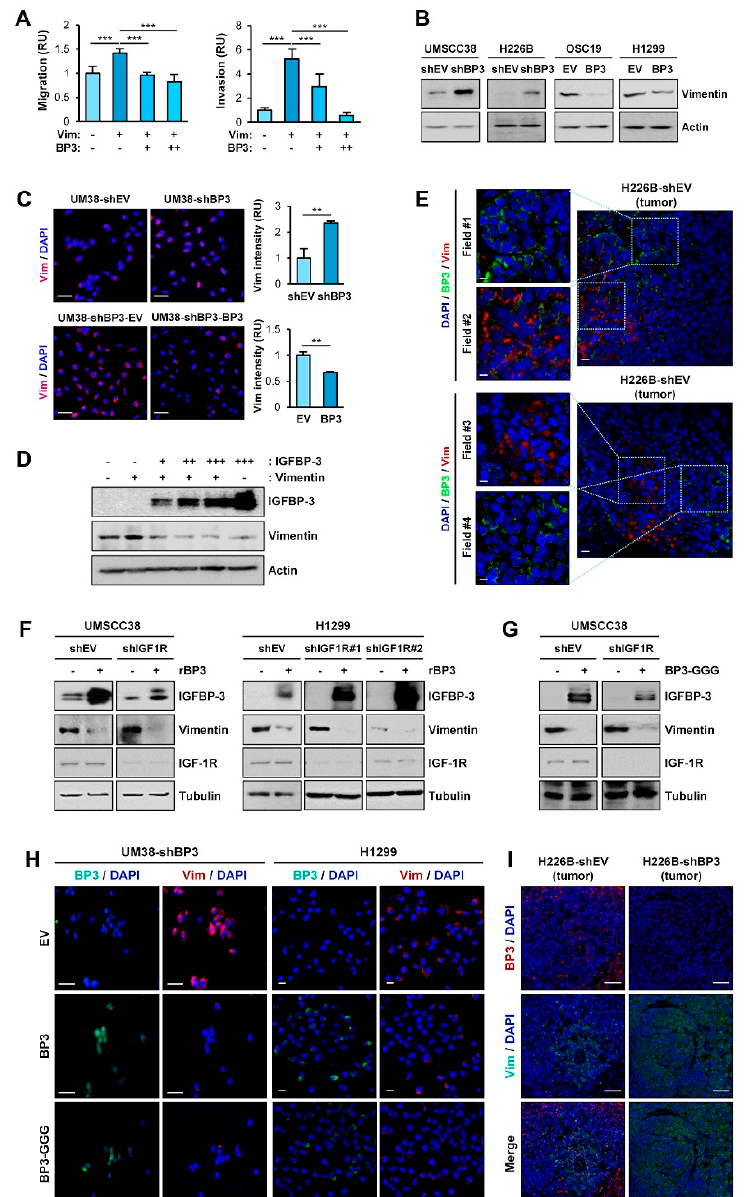
Figure 3. IGFBP-3 negatively regulates vimentin protein expression in an IGF-independent manner. ( A ) Transwell migration and invasion analyses of OSC19-Luc cells in which pEGFP-vimentin (Vim) was transiently transfected, either alone or together with increasing concentrations of expression vector carrying IGFBP-3 (BP3). ( B , C ) Western blot (WB) ( B ) and IF ( C ) analyses of vimentin expression in the indicated cancer cells with enforced overexpression or knockdown of IGFBP-3. Scale bars: 50 µ m ( C ). ( D ) Dose-dependent inhibition of vimentin protein expression by overexpression of IGFBP-3. OSC19- Luc cells were transiently transfected with empty vectors (-, pEGFP and pCMV6), pEGFP-vimentin and increasing amounts of pCMV6-IGFBP-3 for 48 h. The expression levels of IGFBP-3 and vimentin were determined by WB analysis. ( E ) Inverse correlation between IGFBP-3 and vimentin expression in H226B-shEV tumor xenografts was determined by IF analysis. Scale bars: 10 µ m ( left ), 20 µ m ( right ). ( F–H ) WB ( F , G ) and IF( H ) analyses of vimentin expression in the indicated cancer cells following treatment with recombinant IGFBP-3 protein ( F ) or transient transfection with empty vector [- ( G ) or EV ( H )], pCMV6-IGFBP3 (BP3), or pCMV6-IGFBP3-GGG (BP3-GGG) ( G , H ). Scale bars: 50 µ m ( H, left ), 20 µ m ( H, right ). ( I ) IF analysis showing upregulation of vimentin expression in H226B-shBP3 tumors compared with H226B-EV tumors. Scale bars: 50 µ m. The bar represents mean ± SD. ** p < 0.01 and *** p < 0.001, as determined by one-way ANOVA followed by Dunnett’s post-hoc test ( A ) and the two-tailed Student’s t -test compared with the corresponding control ( C ). Vim: vimentin; BP3: IGFBP-3; OSC19: OSC19-Luc; EV: empty